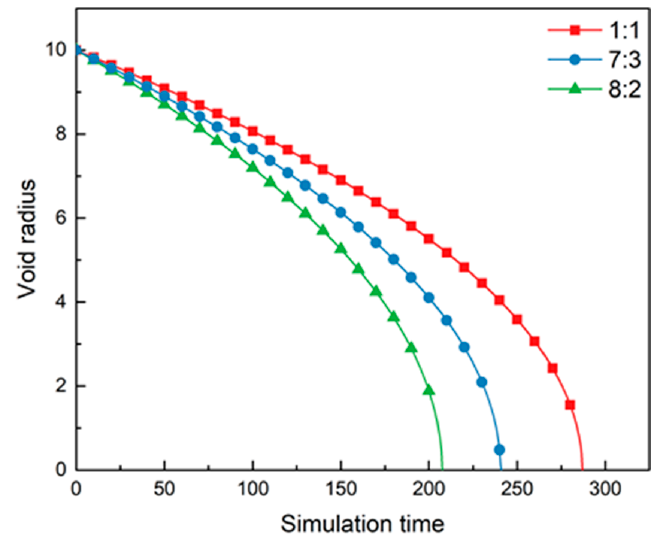
Figure 11. Effect of the void long and short axis ratio on the void healing rate. Since the phase-field method uses dimensionless parameters, the simulation results in Figure 11 are also dimensionless.